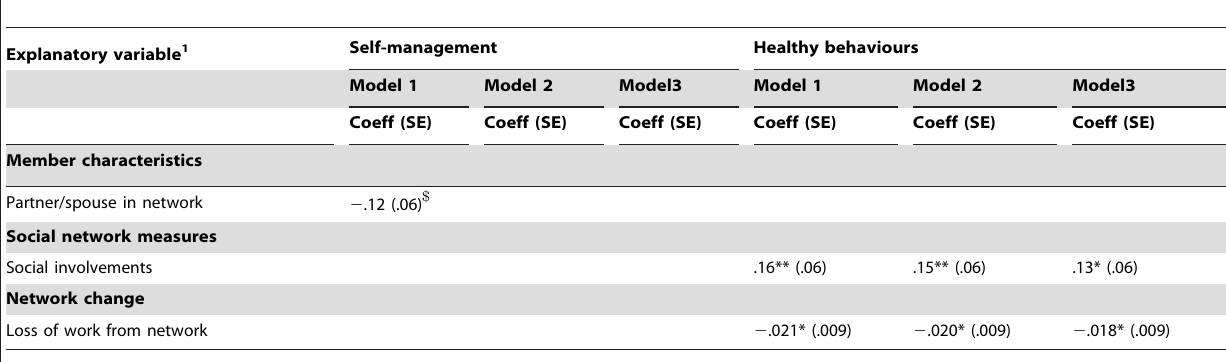
Table 5. Summary of regression analyses of changes in outcomes: Self-management outcomes.